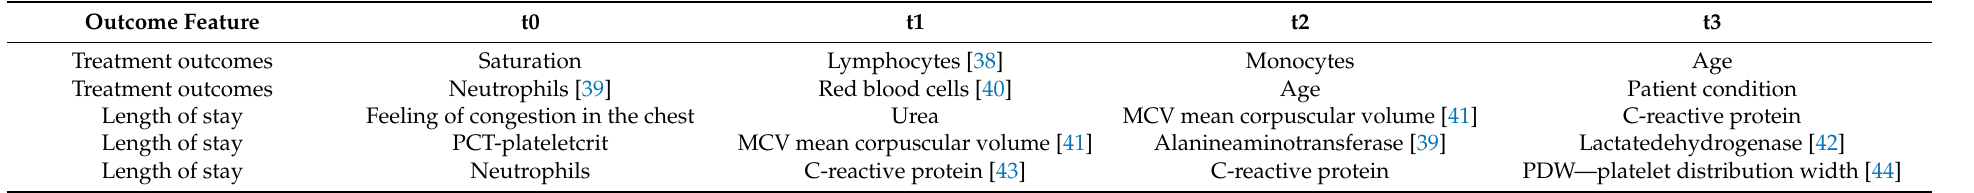
Table 4. Predictors of treatment outcome from four-time